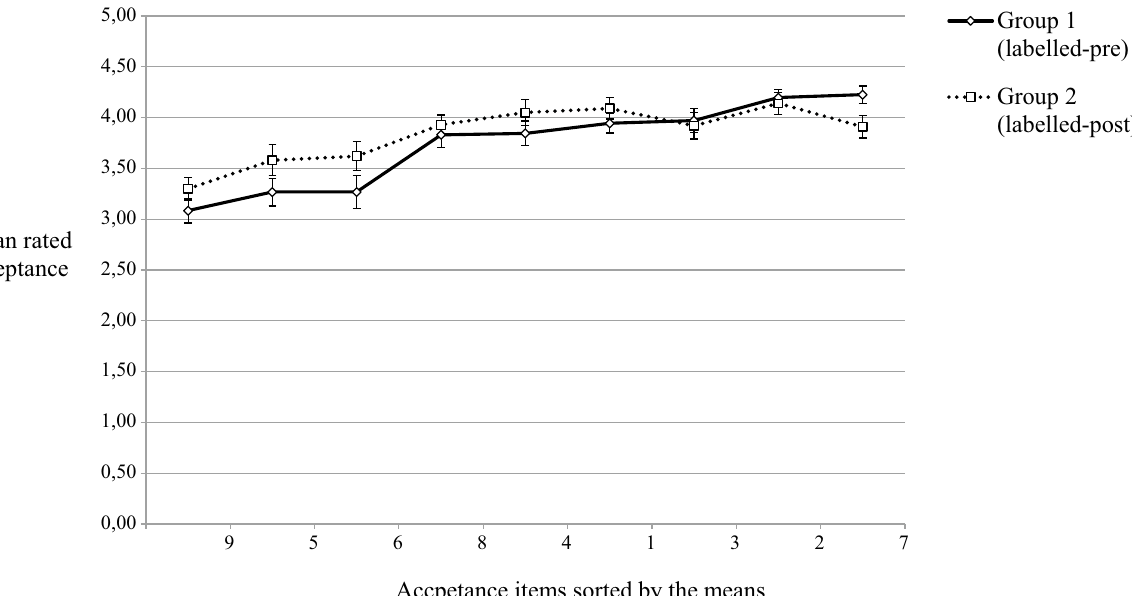
Fig. 3 Means of acceptance items within each group. Ascending order of items is based on the mean ratings in the group 1. Error bars depict the standard errors in rating of each individual item in one specific